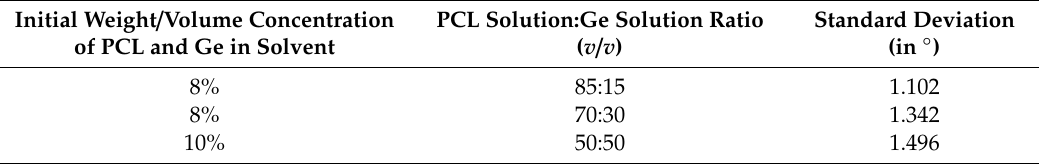
Figure 8. Unidirectional fibre arrangements (SEM, 300×). Table 4. Quantification of Unidirectional Fibre Arrangement (in °).